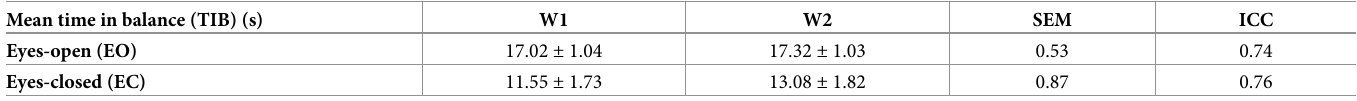
Table 1. Lafayette stability platform test-retest reliability evaluation. Mean time in balance (TIB)